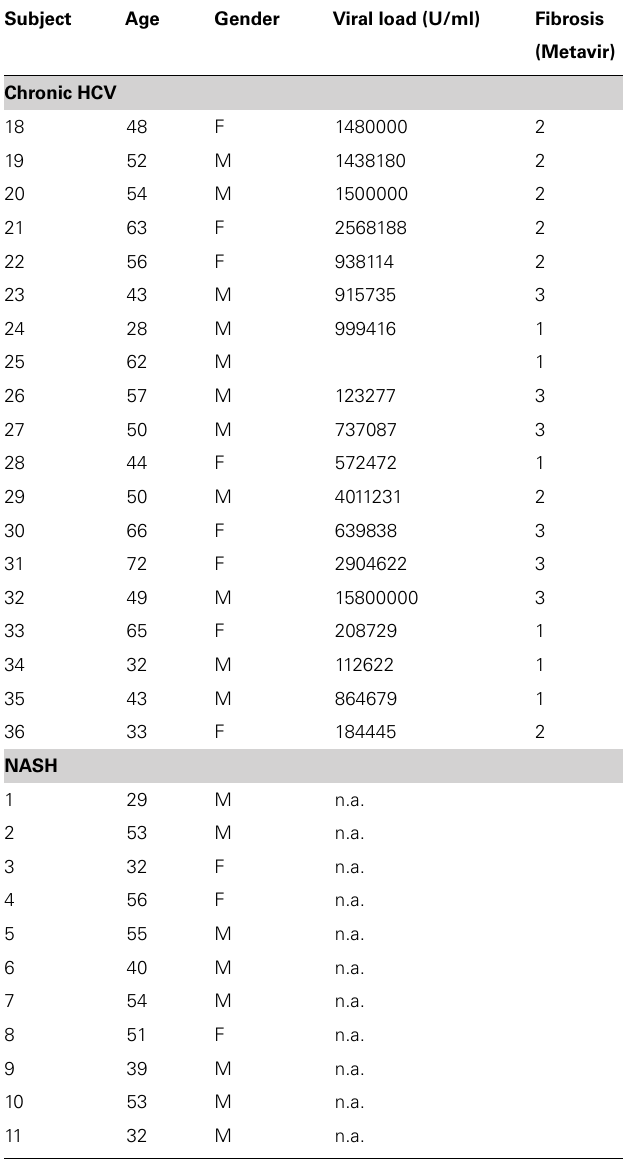
Table 1 | Subject characteristics for in vitro